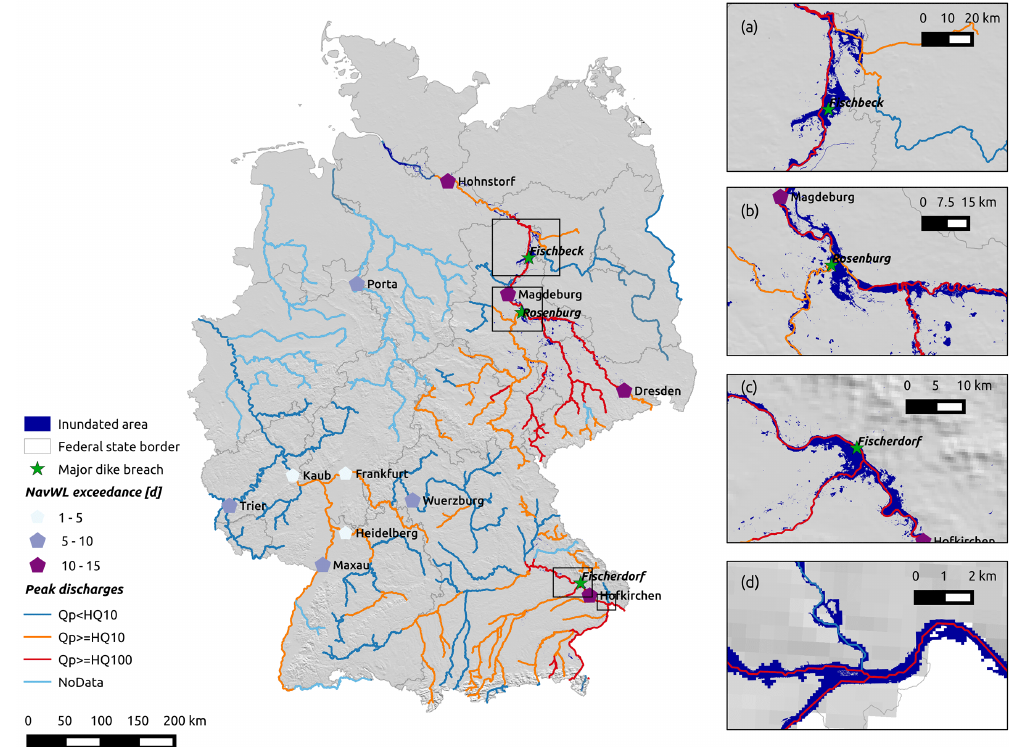
Figure 1. River reaches with flood discharges (Qp) exceeding a 10-year discharge (HQ10) or a 100-year discharge (HQ100), exceedance of highest navigable water level (NavWL) in days at selected gauges (data source: BfG, 2014, p. 152), as well as hot spots of inundation in June 2013 including major dike breach locations; details for (a) Fischbeck, (b) confluence of the rivers Saale and Elbe, (c) Fischerdorf at the confluence of the rivers Isar and Danube as well as (d) the city of Passau (source: Schröter, 2015, based on satellite images of TerraSAR-X and